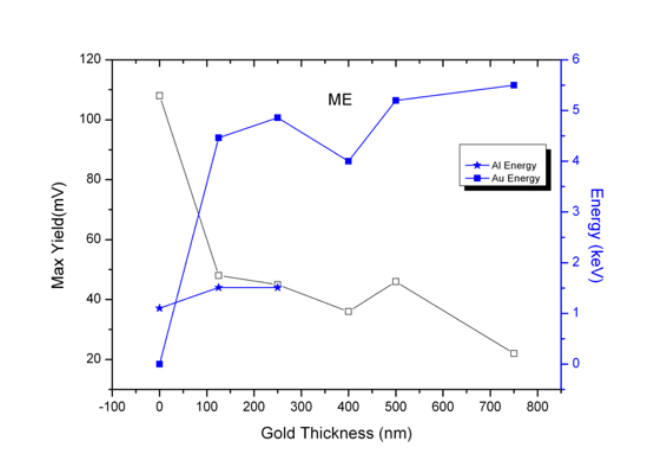
Fig. 7. Experimental results obtained in